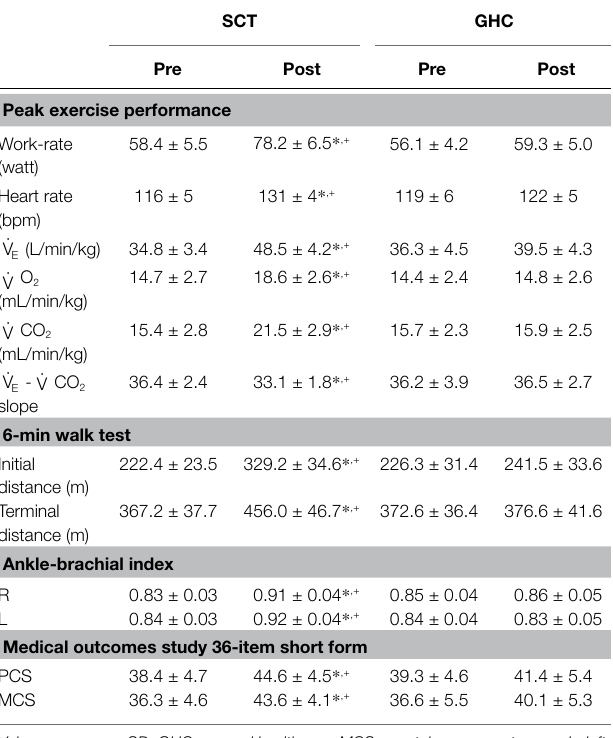
TABLE 1 | Pre- and post-intervention demographic and clinical characteristics of participants with peripheral arterial disease undergoing supervised cycling training (SCT) or general healthcare